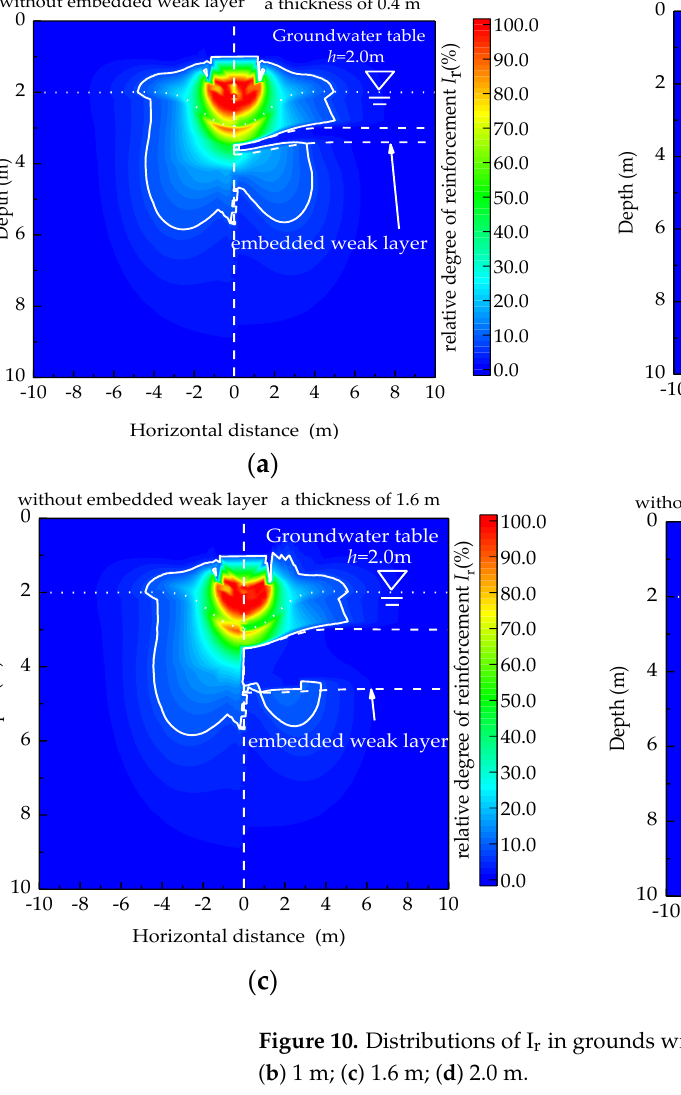
without embedded weak layer a thickness of 1.0 m